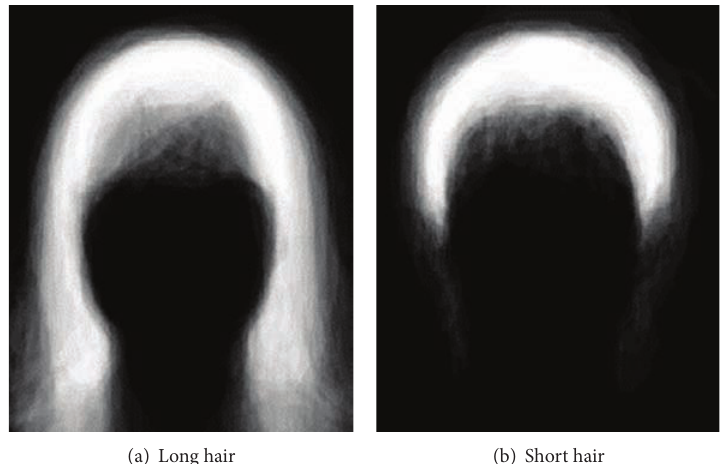
Figure 2: Prior distribution images for hair location. Images are normalized for viewing purpose. The brighter the pixel is the higher the probability is for this pixel belonging to hair region.